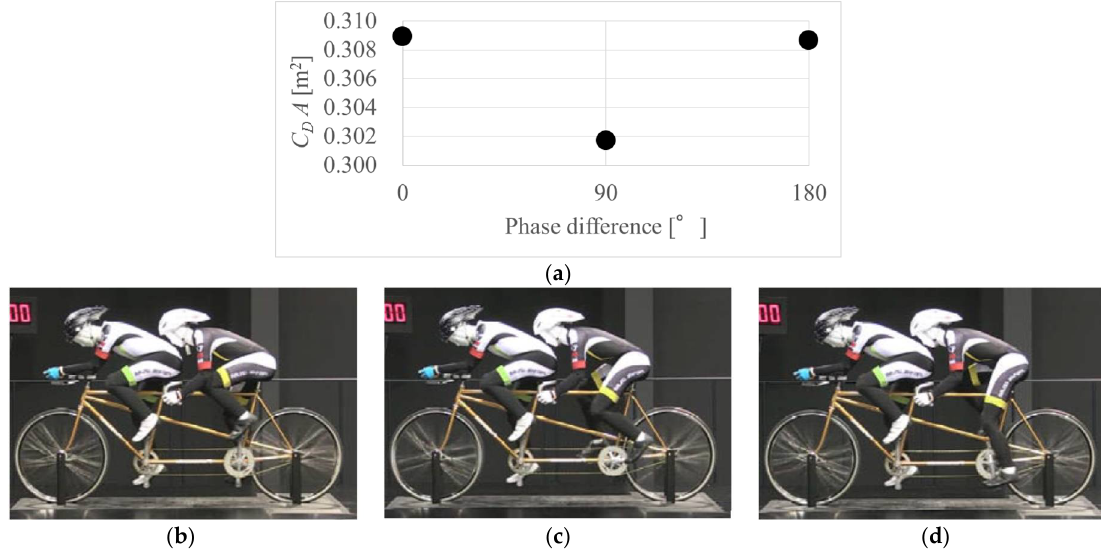
Figure 5. C D A as a function of the phase difference between the crank angle of the pilot and that of the stoker: ( a ) Drag vs phase difference; ( b ) 0 degrees; ( c ) 90 degrees; ( d ) 180